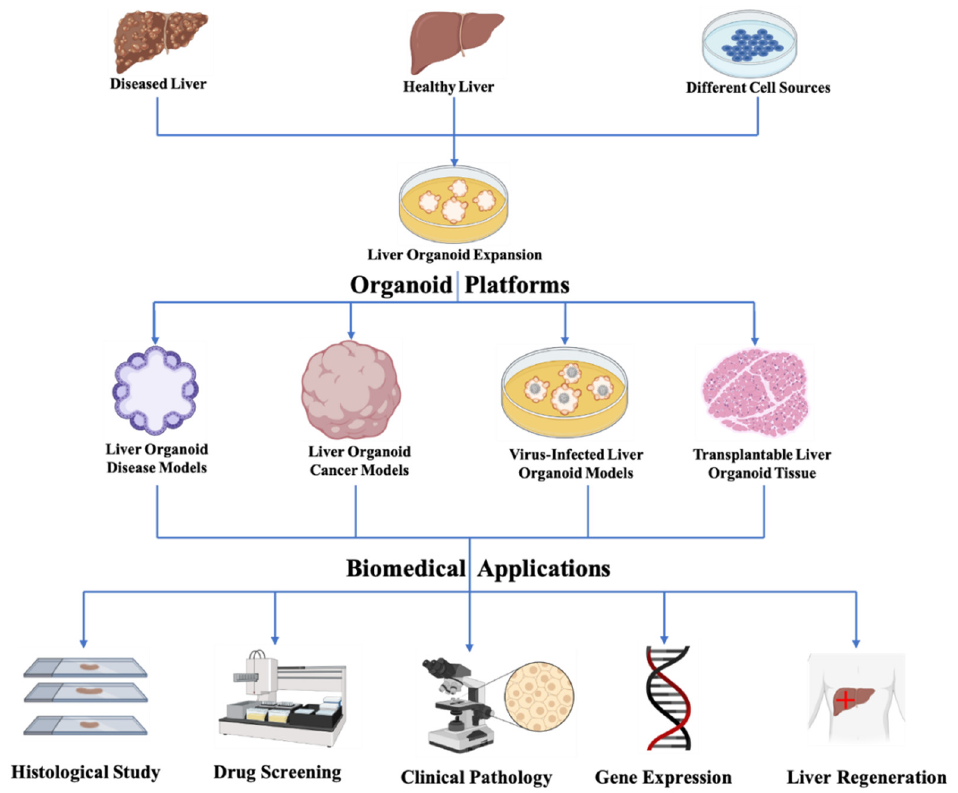
Figure 2. Bioengineering liver organoids derived from various sources to construct disease models, cancer models, virus-infected models, and transplantable organoid tissue for their application in histological study, drug screening, clinical pathology, gene expression analysis, and regeneration.